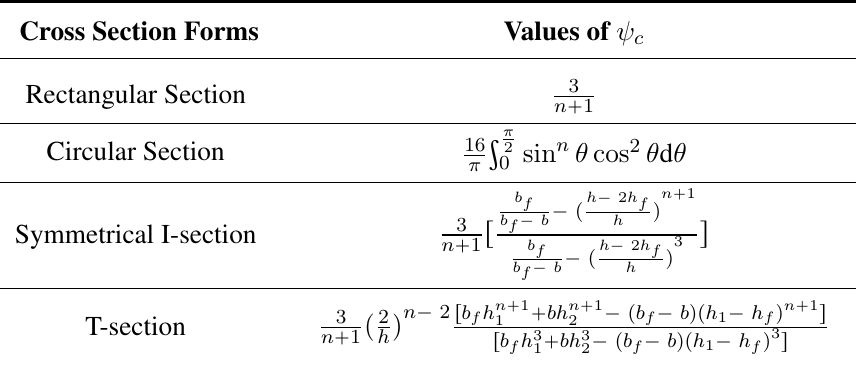
Table 1. Values of ψ